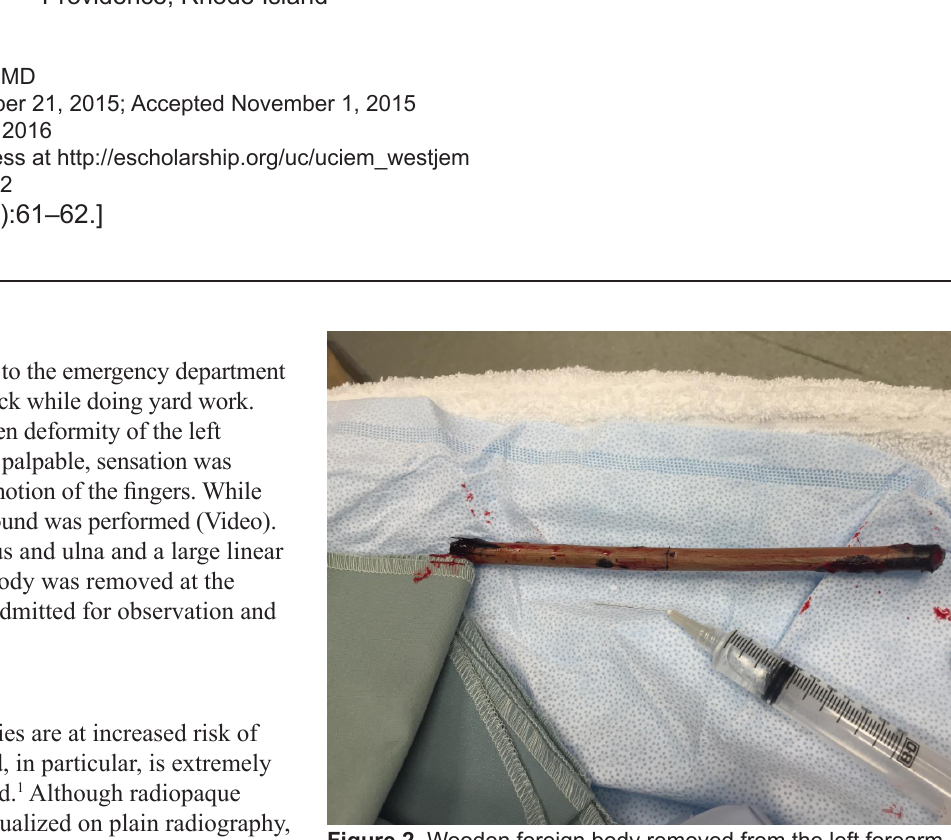
Figure 2. Wooden foreign body removed from the left